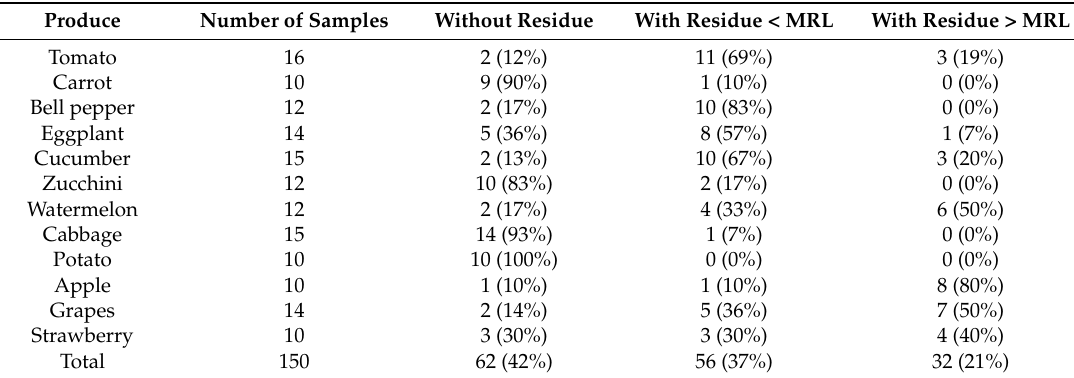
Table 2. Number of fruit and vegetable samples without pesticide residue, and with residue below the maximum residue limits (MRL) and above the MRL a